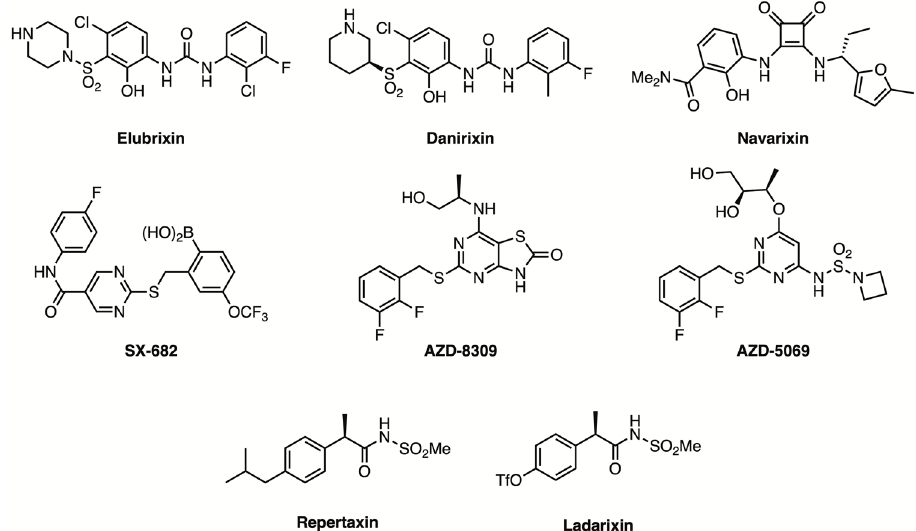
Figure 1. CXCR2 antagonists evaluated in clinical trials .